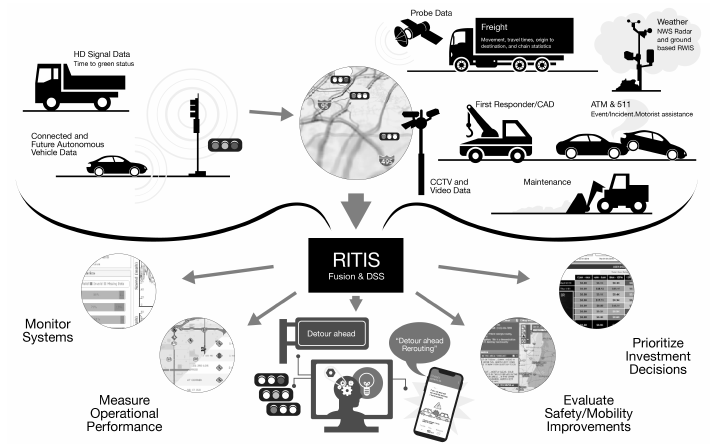
Figure 2. RITIS integrates existing public/private data, adapted from its website [19] and modified. Figure 2. The Regional Integrated Transportation Information System (RITIS) integrates existing public / private data, adapted from its website [19] and